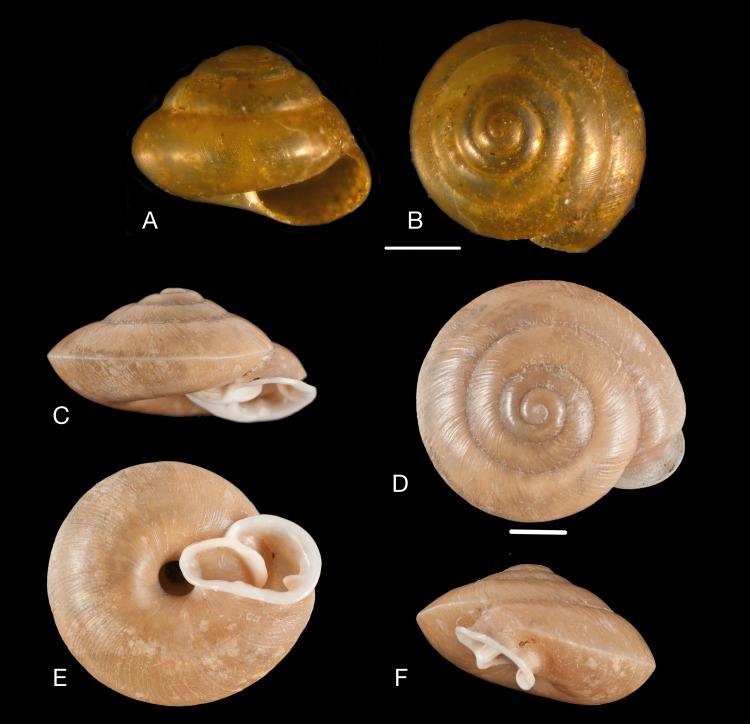
Material collected by the CCP.(A–B) Euconulidae. Euconulus martinezi (Hidalgo, 1869), MNCN 15.05/3190, (A) ventral view, (B) apical view. (C–F) Pleurodontidae. Labyrinthus manueli
Higgins, 1872, MNCN 15.05/13803, (C) ventral view, (D) apical view, (E) umbilical view, (F) lateral view (lip). Scale line 1 mm (A–B), 5 mm (C–F).